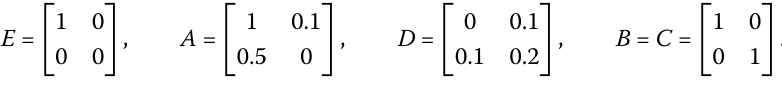
where t ∈ [0,14], the time delay τ = 1,